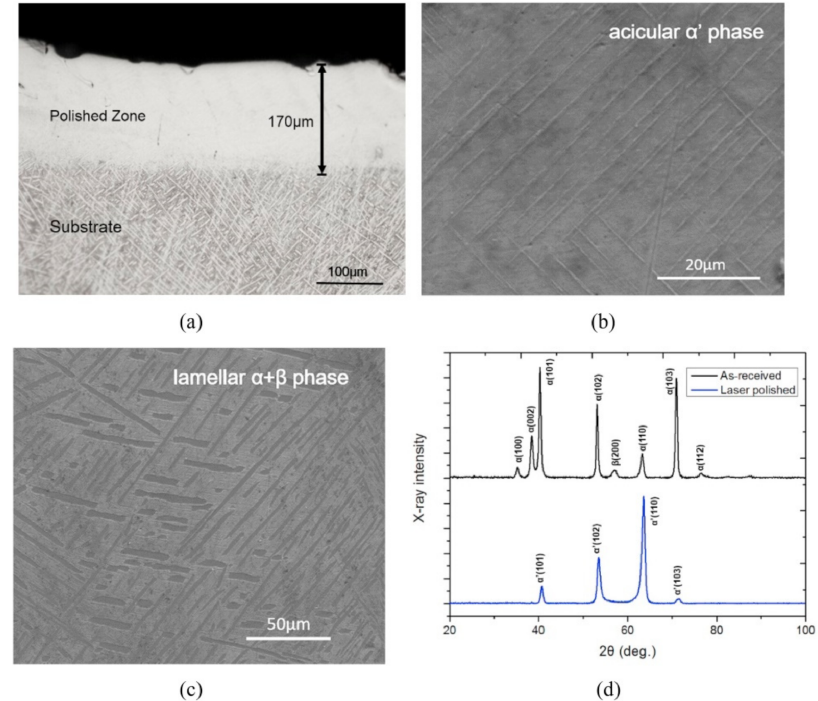
Figure 13. Schematic diagram of microstructure analysis for TC4 surface manufactured by laser AM. ( a ) Overview of the substrate and laser-polished region. ( b ) Microstructure of the laser-polished region. ( c ) Microstructure of the substrate. ( d ) XRD profiles. (Reprinted with permission from ref. [117]. Copyright 2017